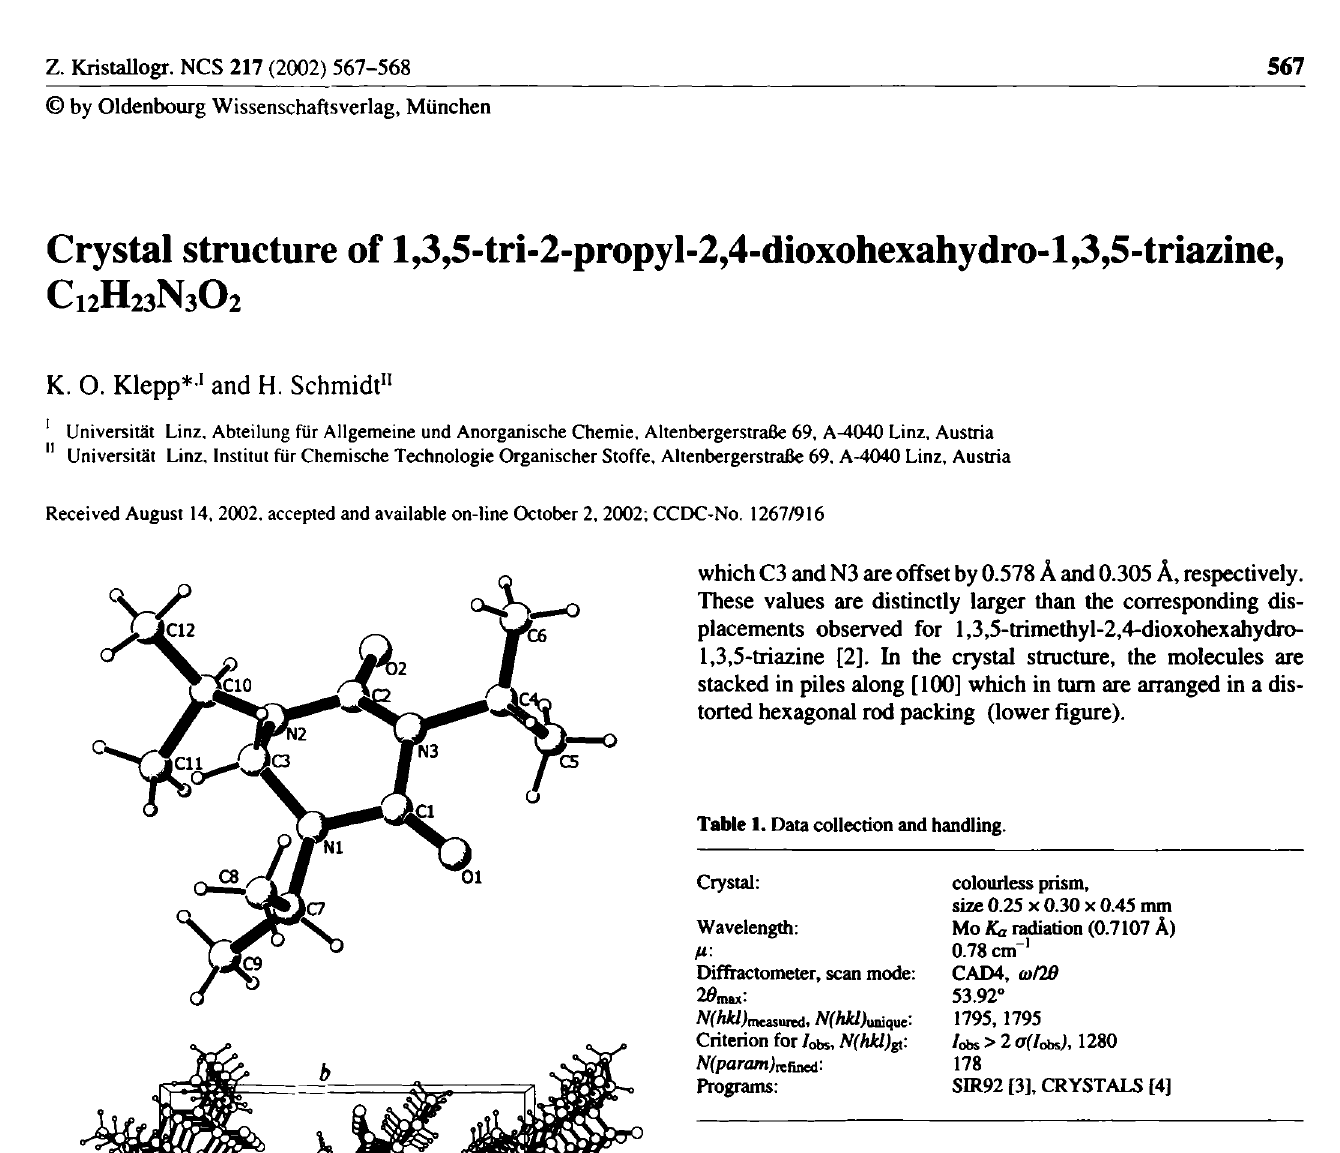
Table 2. Atomic coordinates and displacement parameters (in Â 2